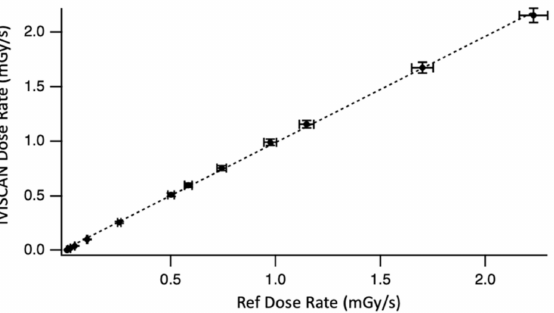
Figure 7. IVISCAN ® response related to LNHB air wall chamber WK07 for low dose rate between 0.005 and 2 mGy/s and RQT9 radiation quality.